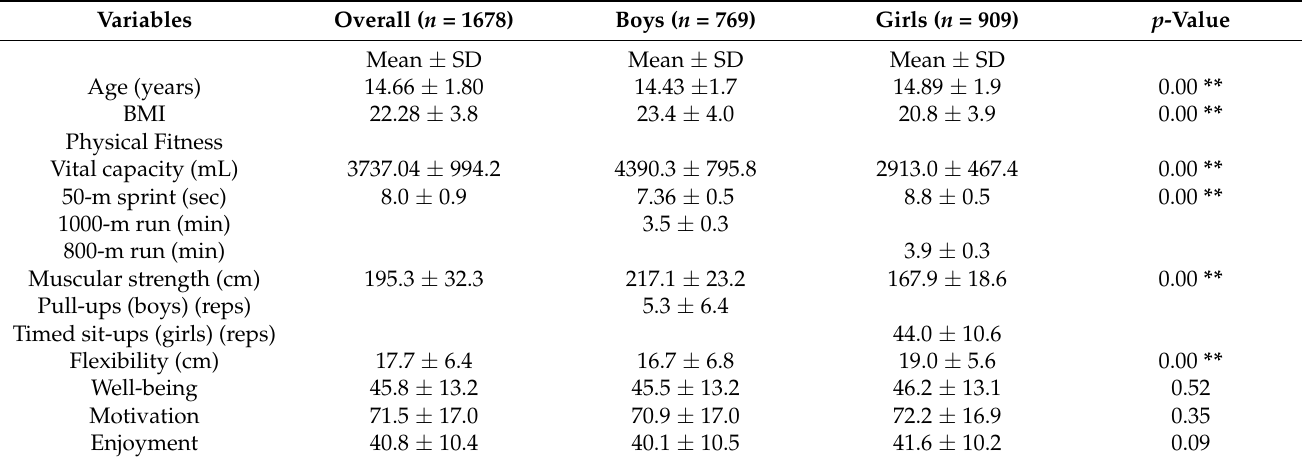
Table 1. Descriptive Characteristics of the Study Sample.